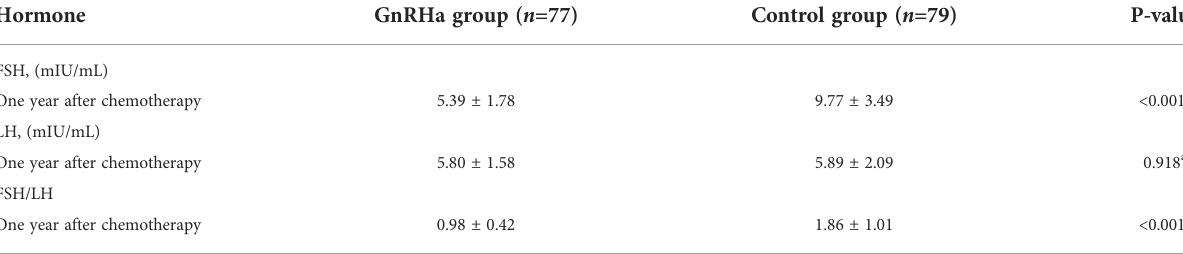
TABLE 3 Hormone levels of the two groups one year after chemotherapy (x ±